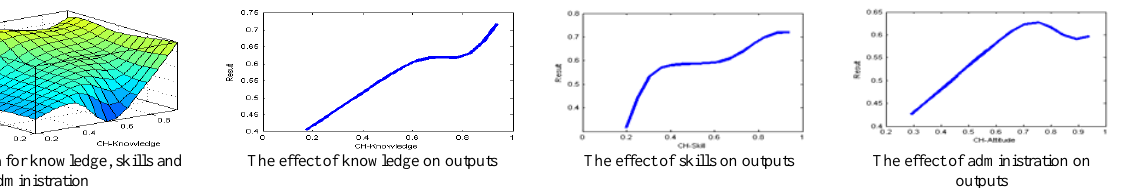
Fig. 5. The results of different factors on outputs